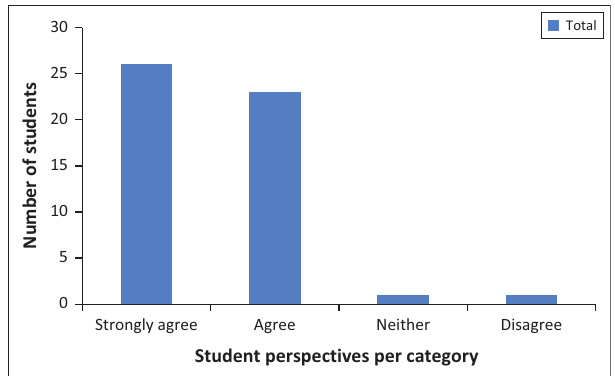
FIGURE 1: Post-workshop understanding of the assignment